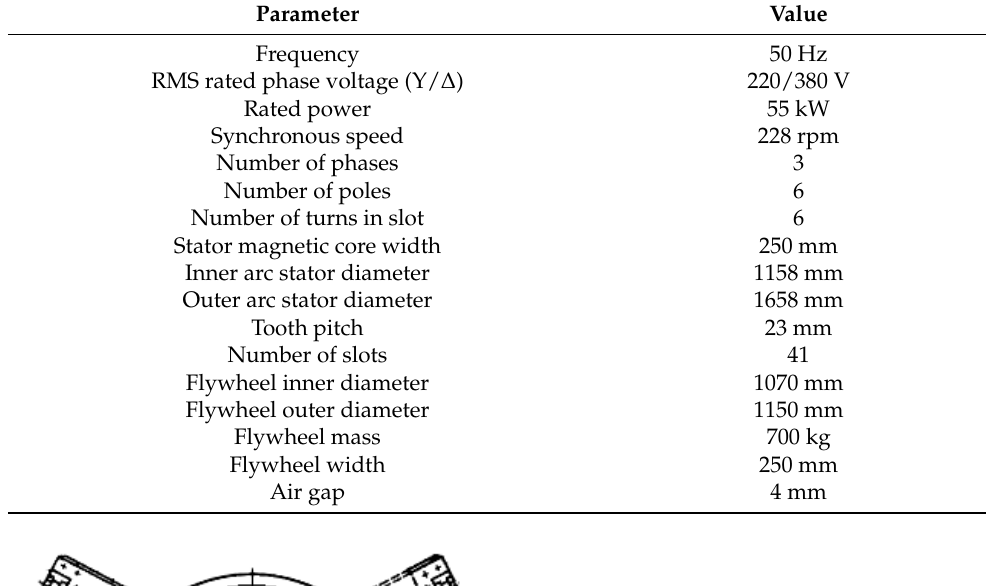
Figure 13. Arc stators of the screw press arc IM before mounting.